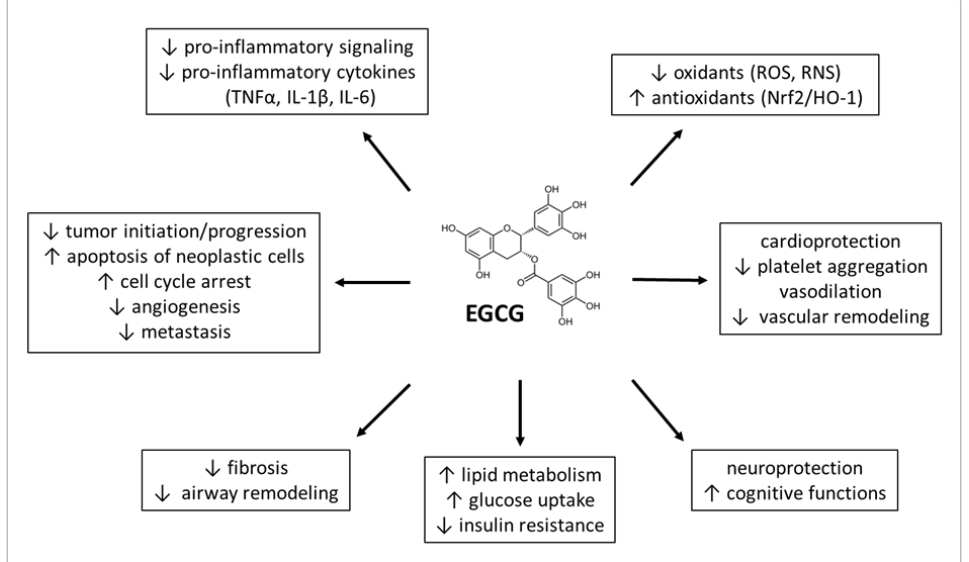
Figure 3. Pharmacological effects and therapeutic benefits of EGCG. Abbreviations: EGCG: epigallocatechin-3-gallate, HO-1: heme oxygenase, IL: interleukin, Nrf2: nuclear factor erythroid 2-related factor 2, RNS: reactive nitrogen species, ROS: reactive oxygen species, TNF: tumor necrosis factor, ↑ : increase, ↓ : decrease.